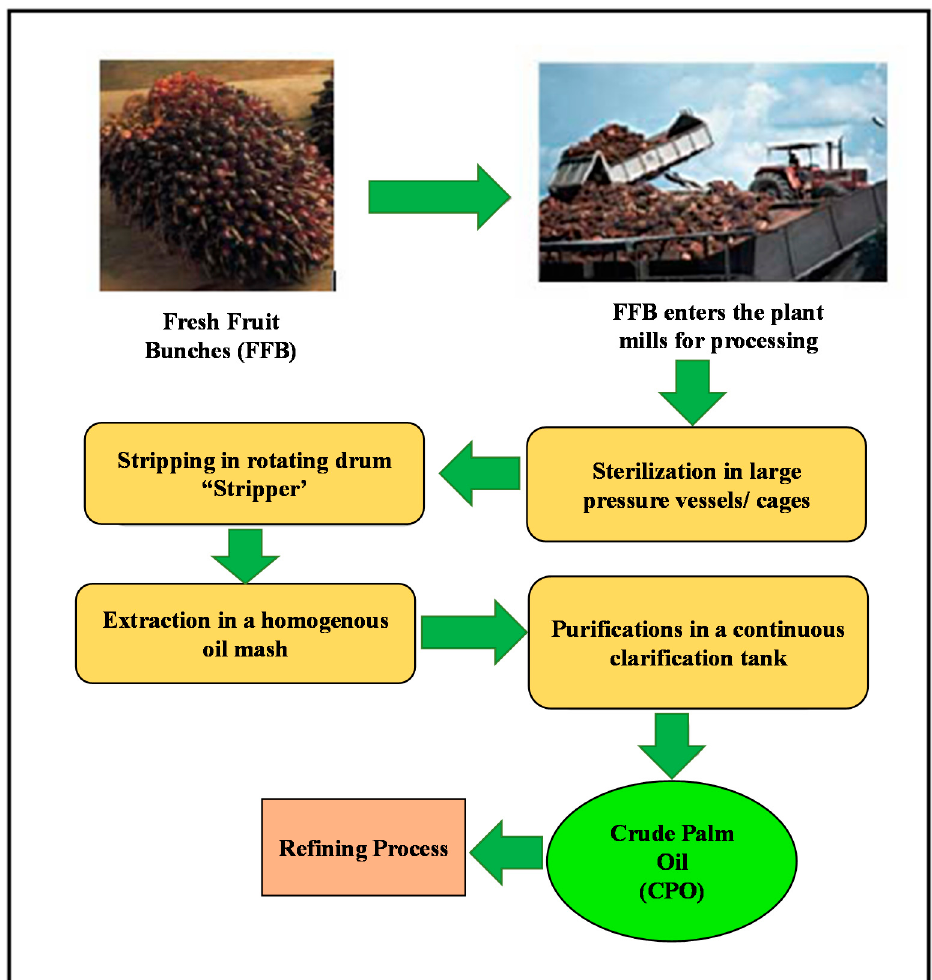
Figure 2. Palm oil refining process. Table 2. The main compounds in Malaysian crude palm oil (CPO).